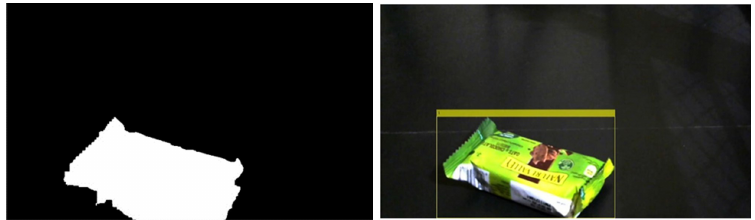
Figure 14. Foreground mask and tracking of the detected item.